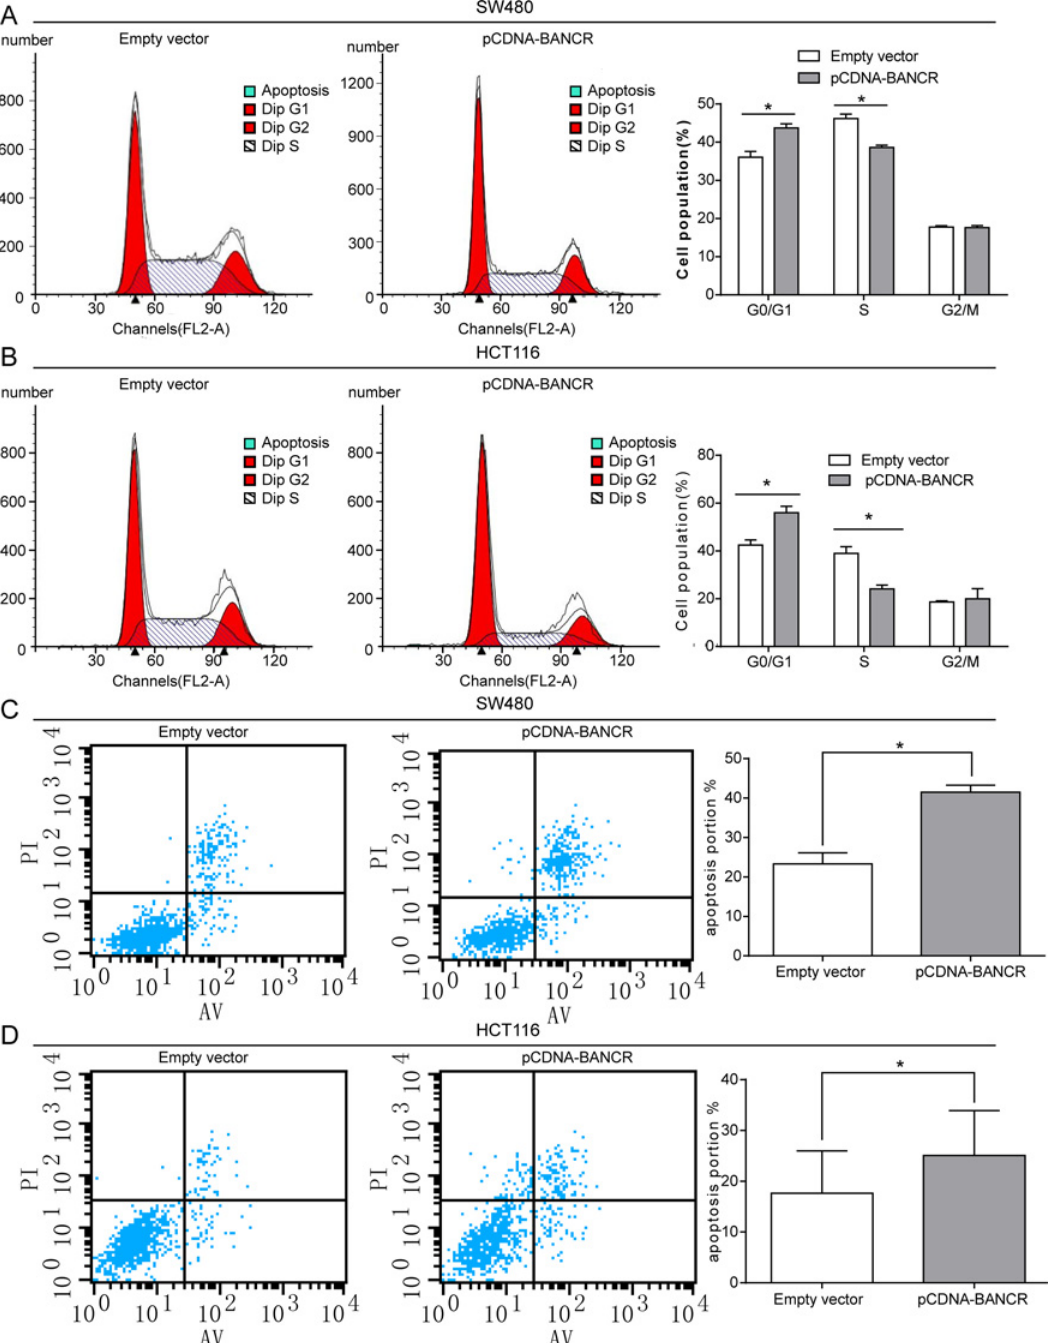
Fig 3. The effect of BANCR on colorectal cancer cell cycle and apoptosis in vitro. (A, B) The bar chart represents the percentage of cells in G0/G1, S, or G2/M phase, as indicated. (C, D) The percentage of apoptotic cells was determined by flow-cytometric analysis. The data represent the mean ± SD from three independent experiments. * , P <